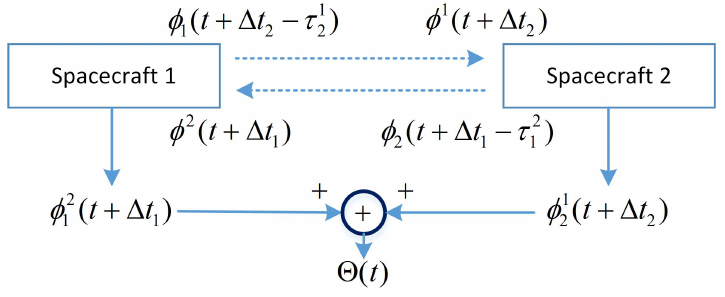
Figure 1. Principle of dual one-way